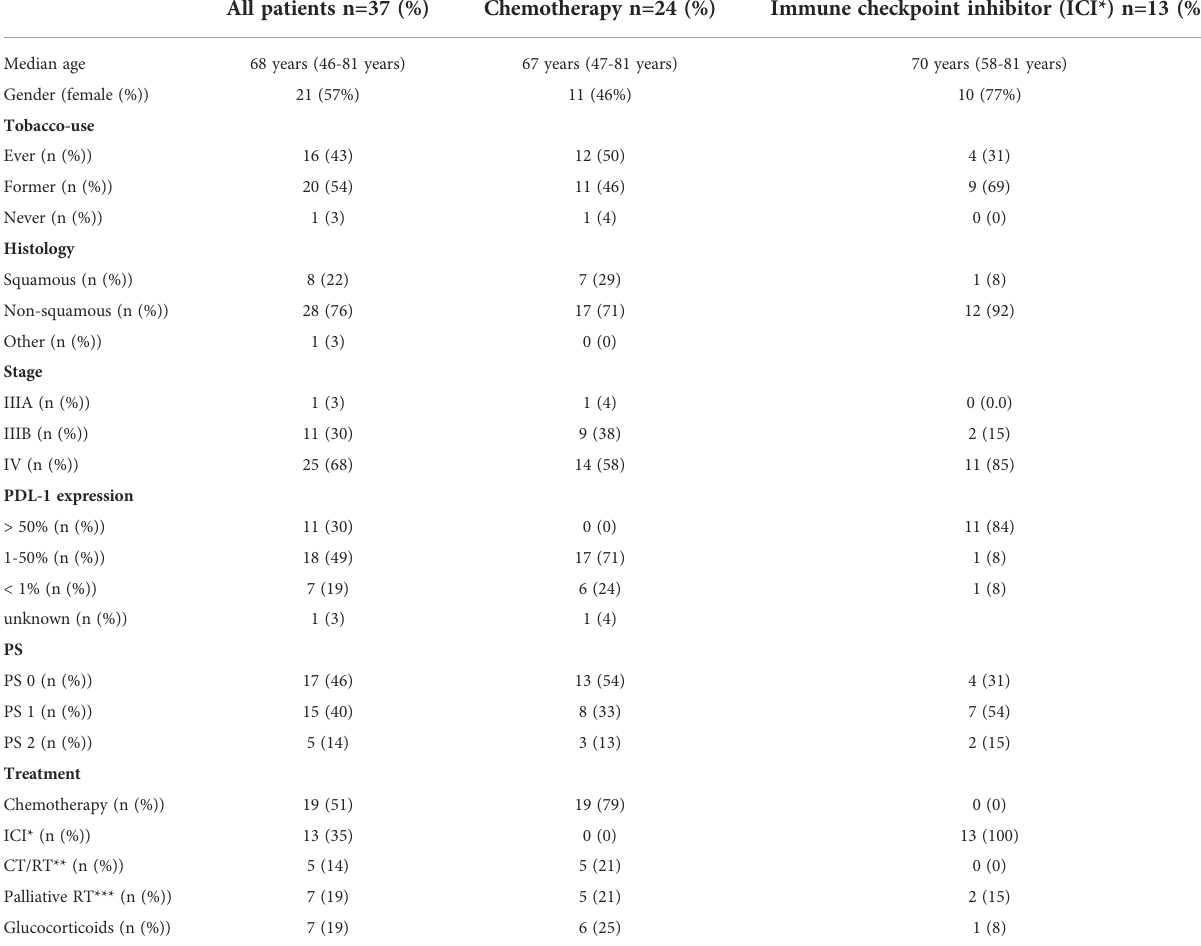
TABLE 1 Patient characteristics for all patients, patients treated with chemotherapy (palliative chemotherapy or concurrent chemoradiotherapy), and palliative immunotherapy. All patients n=37